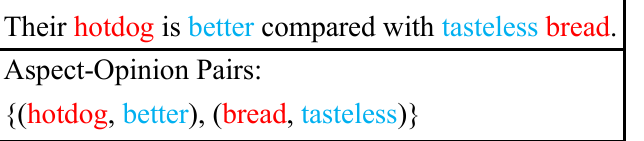
Figure 1. An illustrative example of how the aspect-opinion pairs are expressed in a review sentence. The terms highlighted in red and blue are aspect terms and opinion terms,